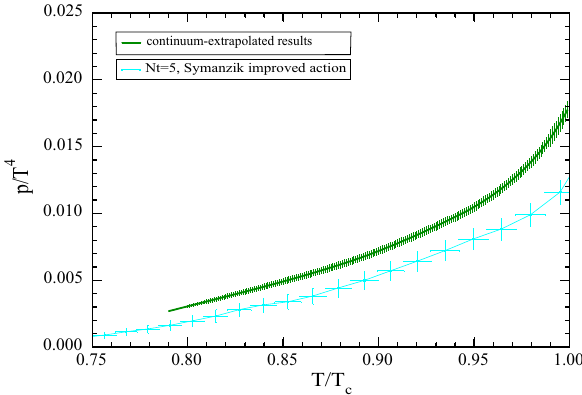
Fig. 17 Comparisonofthepressureinthedeconfinedphase,measured in this work, i.e. SU(2), with the determinations in SU( N c ) of Ref. [16]